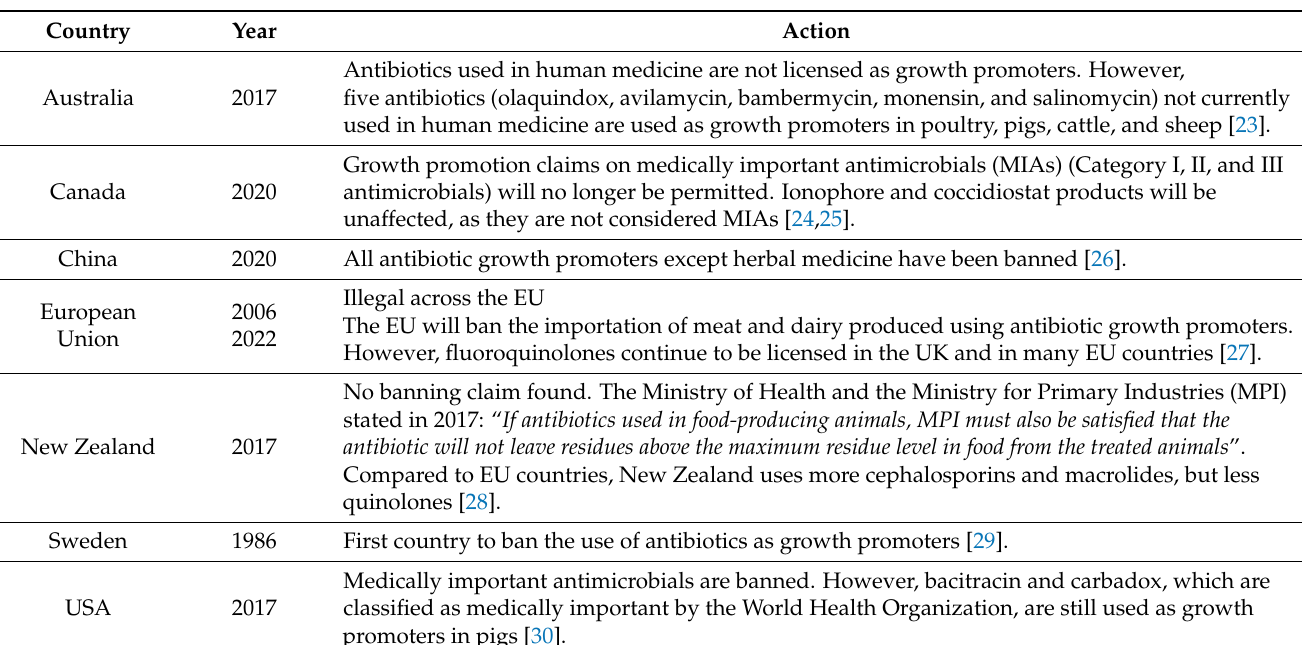
Table 1. Regulations regarding the use of antibiotics as growth promoters in different